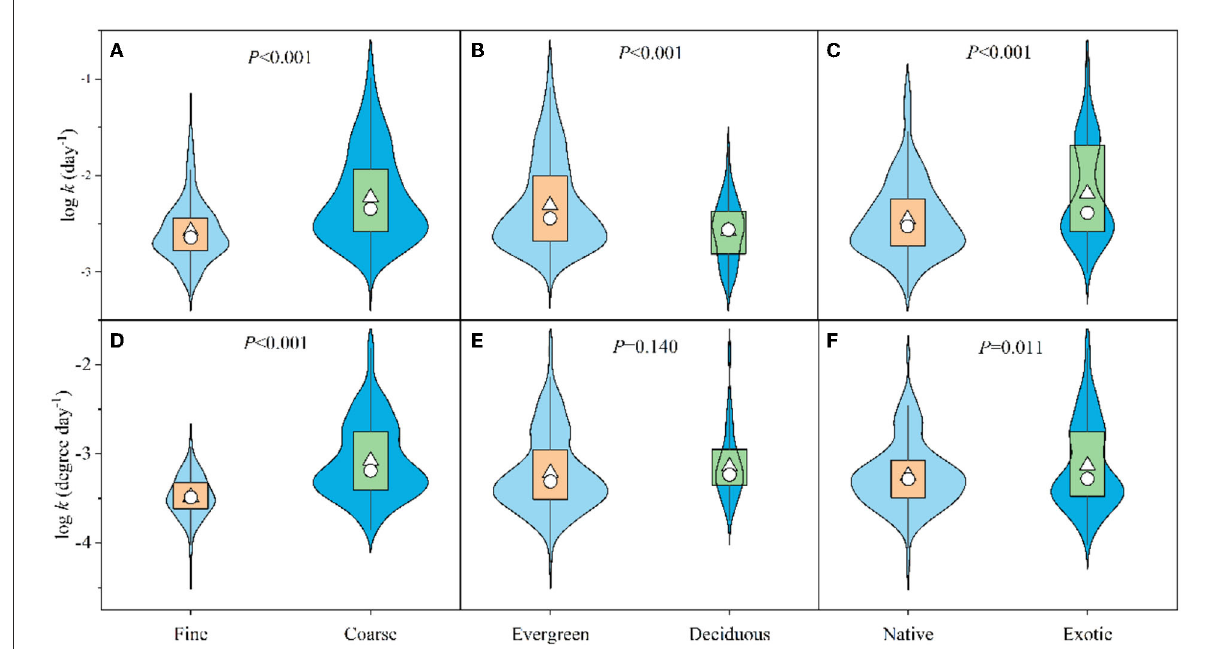
FIGURE3 Comparisons of leaf-litter breakdown rates (per day, upper; per degree day, lower) between coarse and fine mesh bags (A,D) , evergreen and deciduous species (B,E) , and native and exotic species (C,F) . Box plots summarize the distribution of all values. Box plots indicate the interquartile ranges (box part), 25th and 75th percentiles (lower and upper error bars), median values (circles in the box), and mean values (triangles in the box).